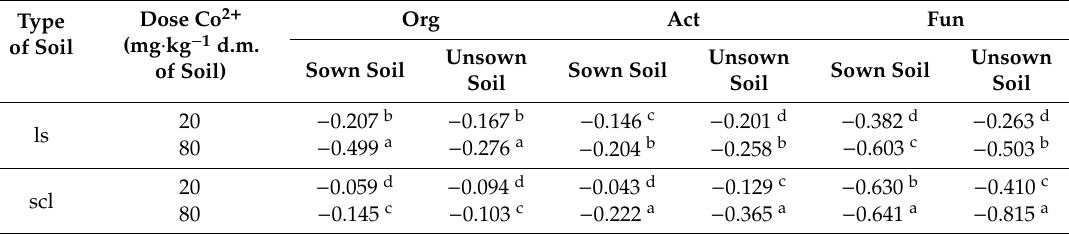
Table 6. Index of cobalt e ff ect ( IF Co ) on the microorganism